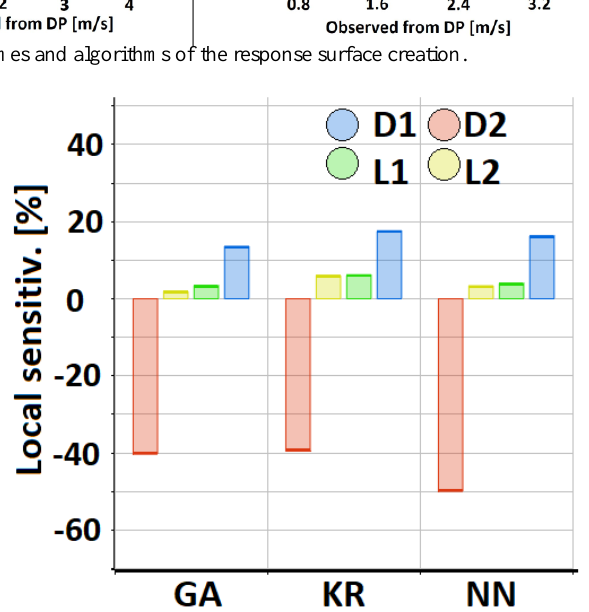
Fig. 6. Local sensitivity of the output parameter (standard deviation) for different response surface designs: GA – genetic aggregation, KR – Kriging, NN – neural network.